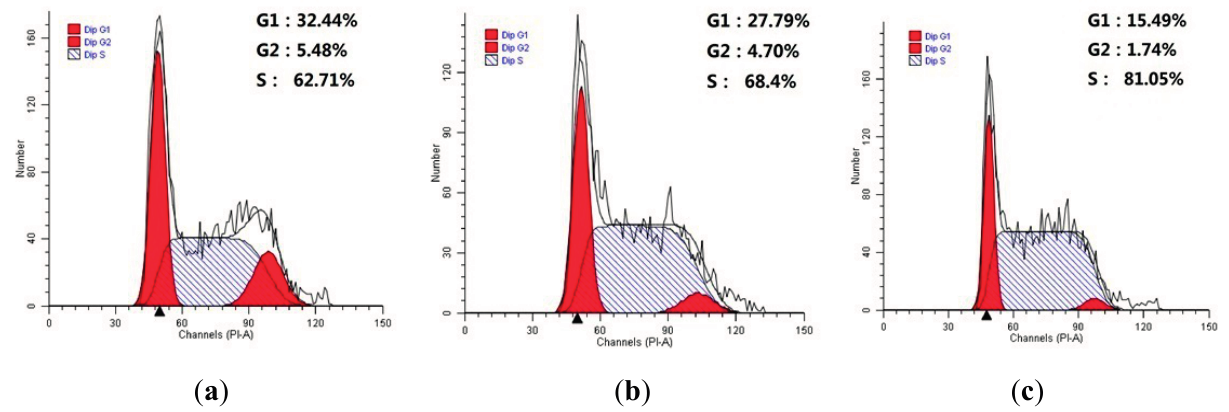
Figure 6. Investigation of cell cycle distribution by flow cytometric analysis. ( a ) Untreated HeLa cells as a control; ( b , c ) Cells treated with increasing concentrations of compound 9n (10, 15 μ M) for 48